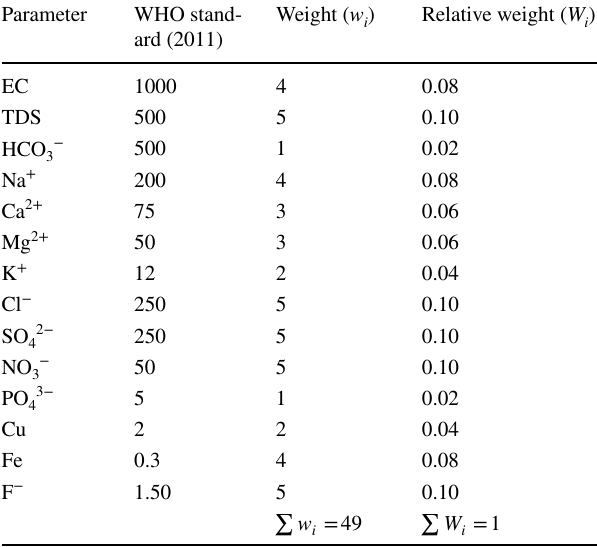
Table 1 Assignment of relative weight to the studied groundwater quality parameters and WHO standards used for WQI calculation [explanation: EC (µS/cm) and all concentrations (mg/l)] Parameter